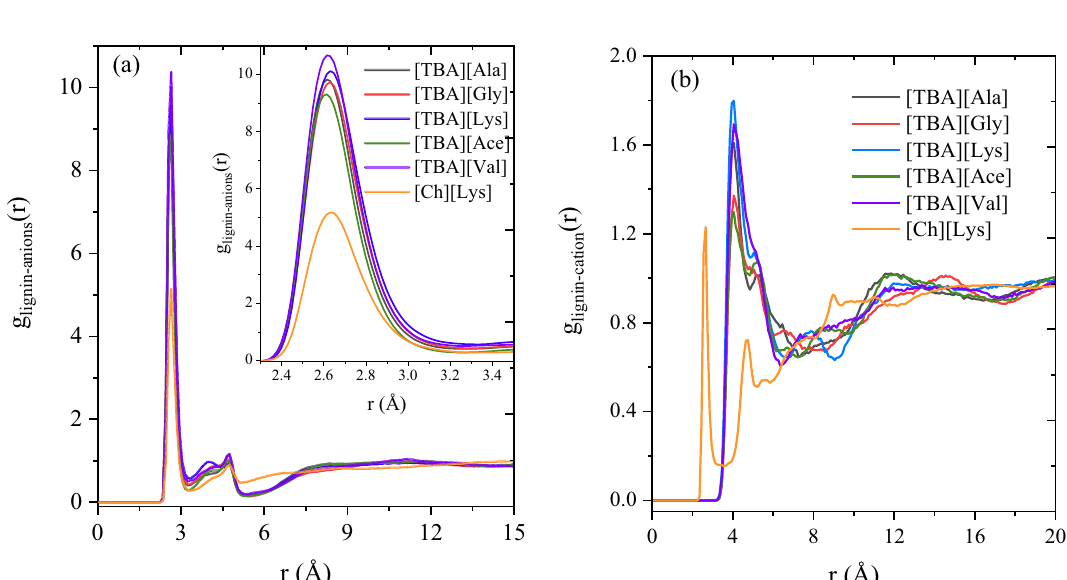
Figure 10. RDF plot between the O atom of lignin with ( a ) O1 atom of anion, and ( b ) N1 atom of cation for different lignin-IL